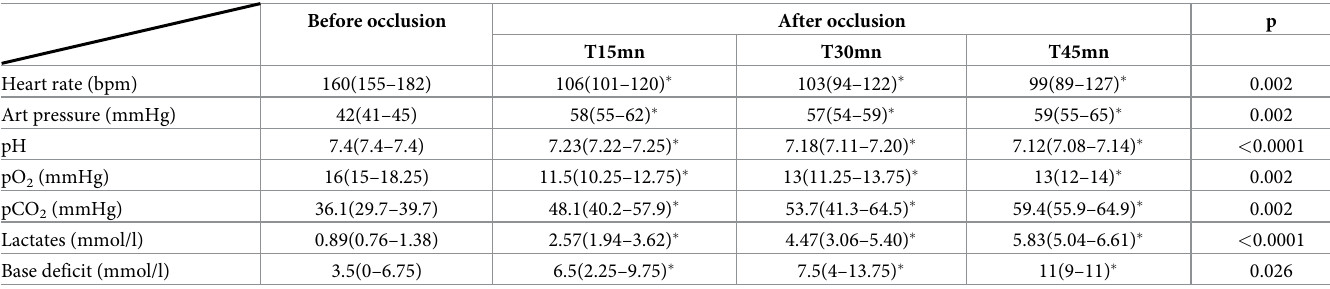
Table 1. Physiological fetal datas in time series (n = 8).